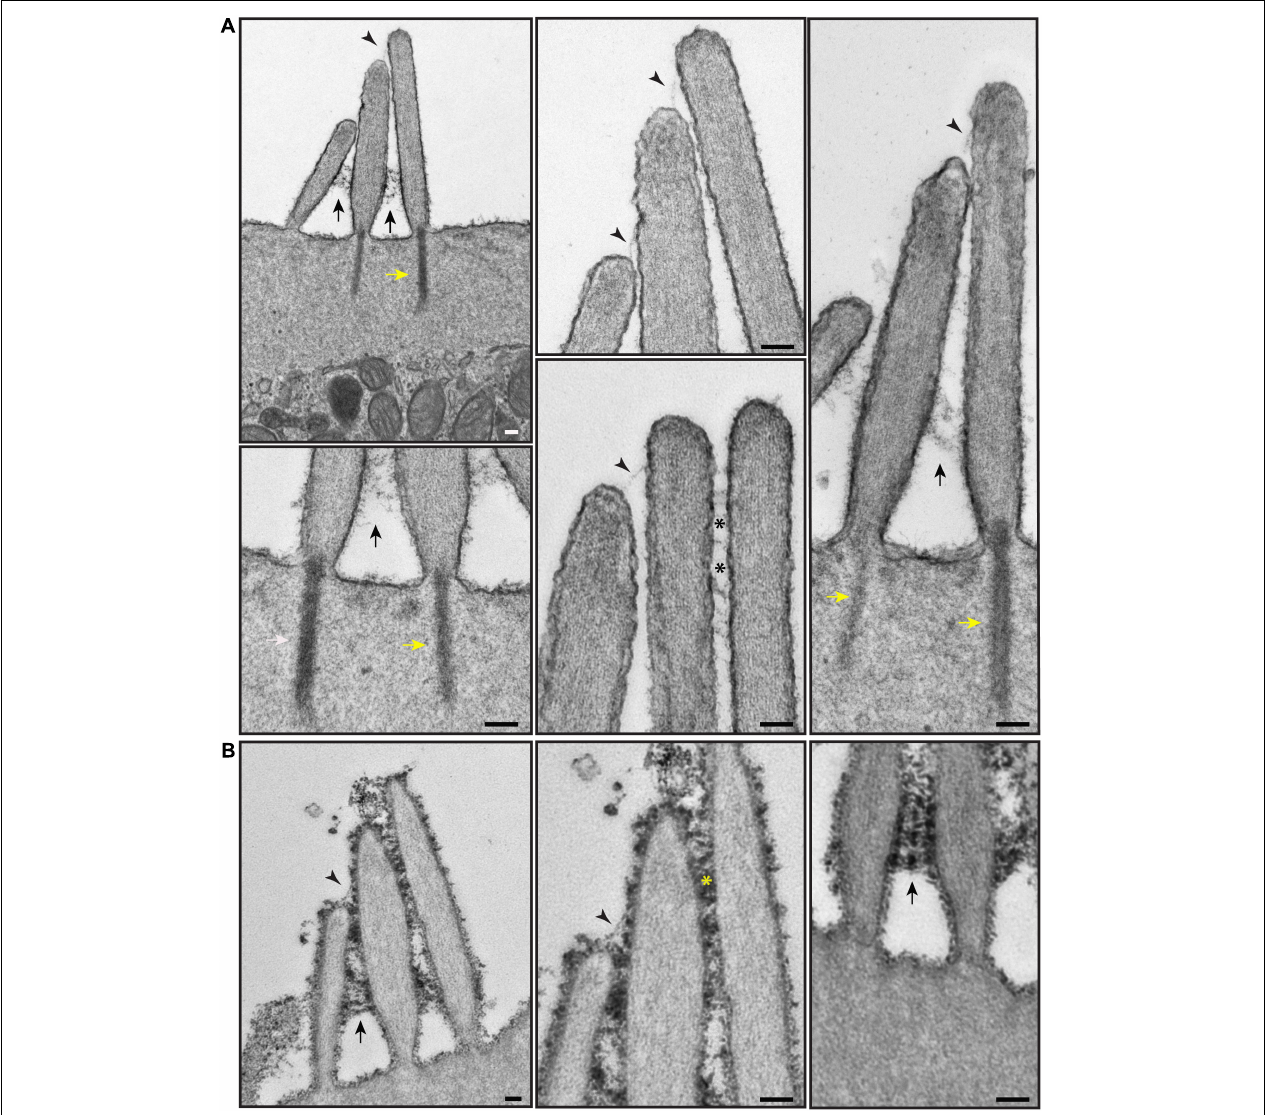
FIGURE 6 | Representative transmission electron micrographs of OHC hair bundles of the neonatal (P4) wild-type mouse cochlea. (A) Samples stained with 1% tannic acid (1 h). (B) Samples stained with 5% tannic acid (overnight). In (A,B) adjacent stereocilia (short, middle, tall) are seen to be connected by tip links (black arrowheads), lateral links (asterisks), and ankle links (black arrows). Yellow arrows point to the rootlets. The cell coat material is better visible on the samples stained with 5% tannic acid. It appears at the surface of stereocilia and the apical non-stereociliary surface. (A,B) Samples were imaged with a JEOL 1200EX microscope operating at 80 kV. Scale bars: (A,B) 100